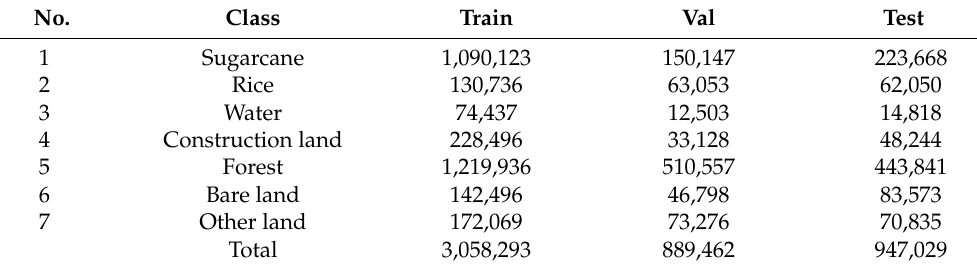
Table 2. Category information of the data in the sample pool of the study